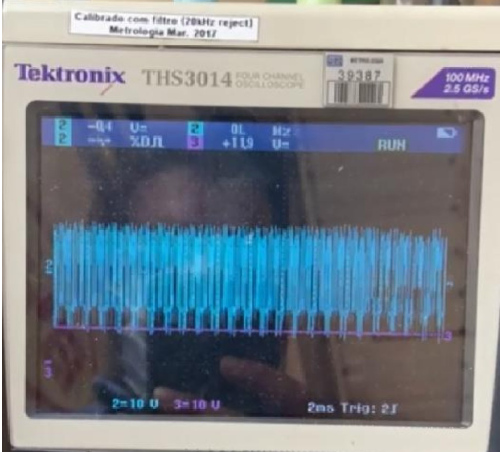
Figure 8. Communication signal between the WEG station and the BYD bus.